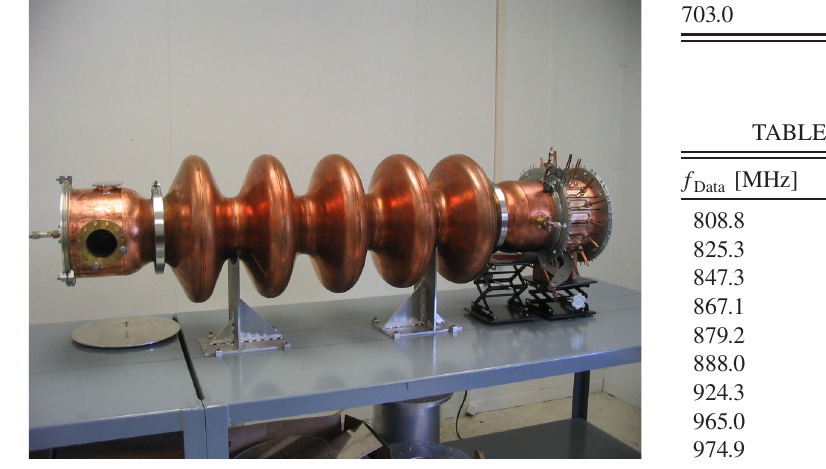
FIG. 2. (Color) The five-cell Cu cavity with prototype ferrite HOM absorber.